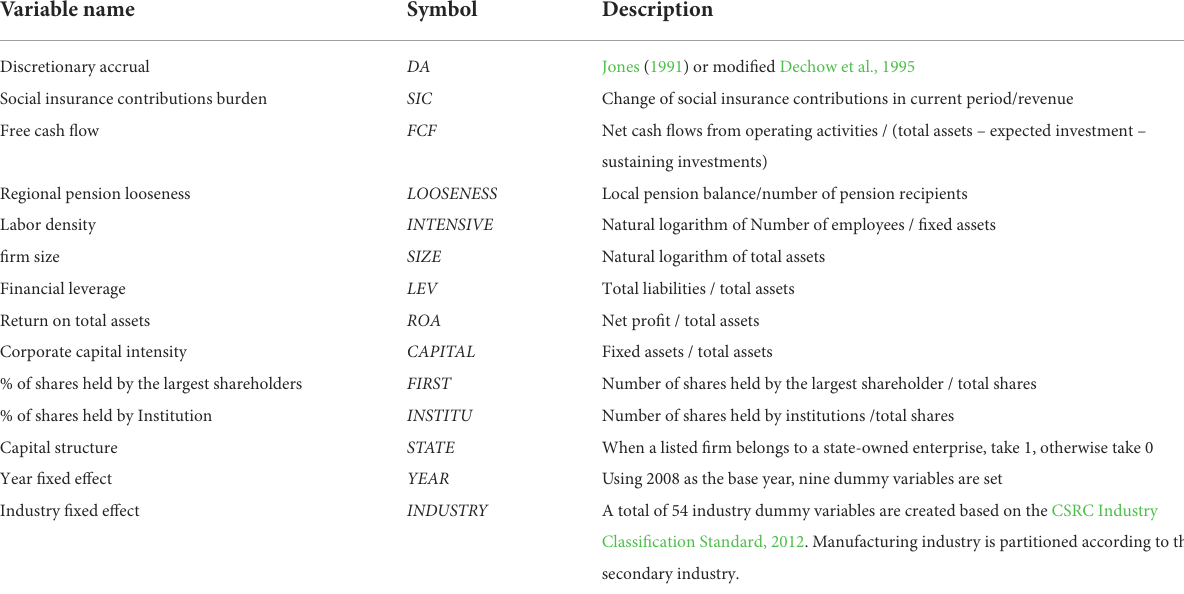
TABLE 1 Definitions of main